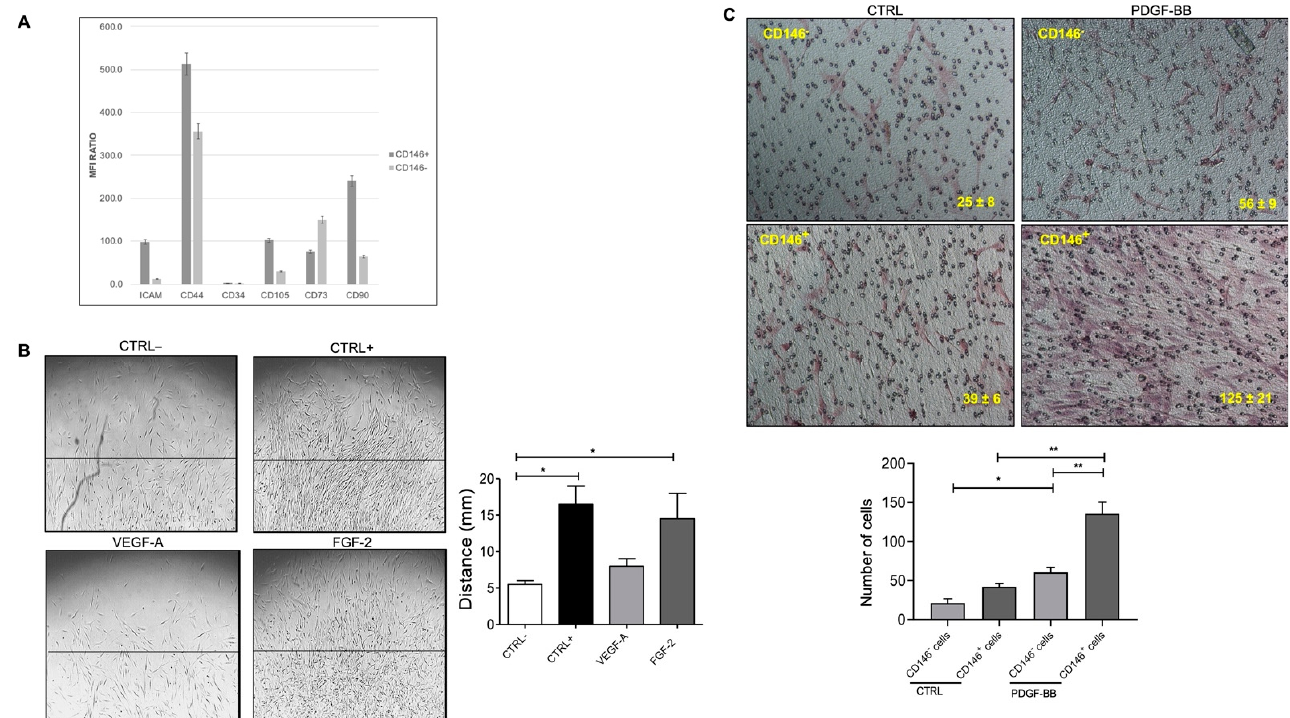
Figure 2. ( A ) The bar graph represents the mean fluorescence intensity (MFI) ratio of each specific antibody and the relative isotype control by flow cytometric analysis of CD146 + and CD146 − cell populations. Values greater than 1 indicate the expression of the specific marker. ( B ) PDGF ‐ BB induced pericyte migration. The presence of FGF ‐ 2 promoted CD31 – PCs migration but not VEGF ‐ A as compared to the negative control (EBM ‐ 2 + 0.5% FBS). PCs stimulated with complete medium (EGM ‐ 2 + 10% FBS) were used as a positive control. The bar chart represents the relative distance migrated outwards from the collagen layer towards the edge of the wells upon stimulation with VEGF ‐ A and FGF ‐ 2. At least 3 different fields/well were counted at 10× magnification in triplicates. Scale bar = 100 μ M. ( C ) PDGF ‐ BB promoted PCs migration for CD146 + cells higher than CD146 cells in the basal medium in a transwell assay. The bar chart represents the number of cells that migrated across the membrane and were counted by microscopically examining the lower surface of the transwell chamber. Reported data represent the means ± standard deviation (SD) of the number of cells found in each field. At least 5 different fields for each membrane were counted at 10× magnifi ‐ cation. Scale bar = 100 μ M. Images are representative of at least three independent experiments with similar results performed in triplicates. Statistical analysis was performed by one way ANOVA and Bonferroni’s post ‐ test; * p < 0.05, ** p < 0.01. CTRL + —positive control; CTRL − —negative control;